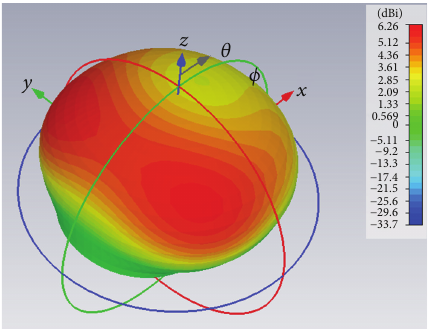
Figure 7: Simulated results for 3D antenna radiation pattern (directivity) of a single antenna element embedded inside the 5- element array at 𝑓 = 900 MHz.